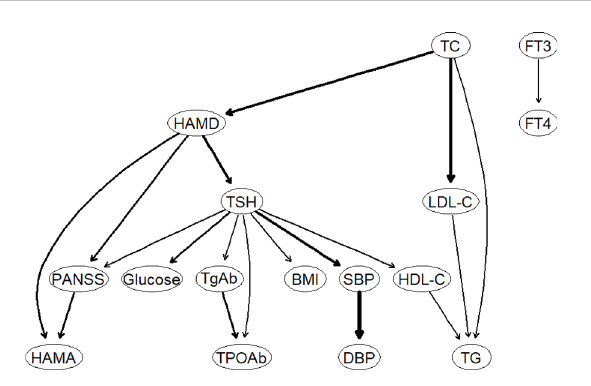
FIGURE 3 The Bayesian network of thyroid hormones, metabolic parameters, and clinical symptoms. HAMD, Hamilton Depression Rating Scale; HAMA, Hamilton Anxiety Rating Scale; PANSS, the Positive and Negative Syndrome Scale; TSH, thyroid-stimulating hormone; FT3, free triiodothyronine; FT4, free thyroxine; TgAb, antithyroglobulin; TPOAb, thyroid peroxidases antibody; TC, total cholesterol; HDL-C, high-density lipoprotein; LDL-C, low-density lipoprotein; TG, total triglycerides; BMI, body mass